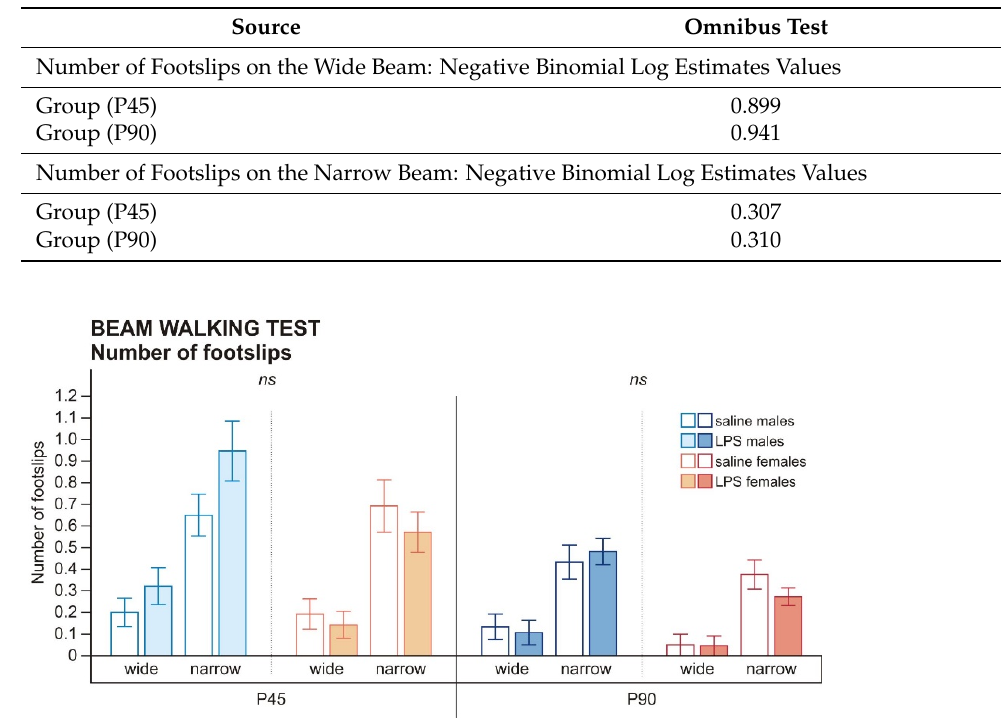
Figure A2. The beam walking test. In general, the number of footslips was very low in all animals, and the difference between LPS-exposed and control rats was revealed neither at P45, nor at P90, by the negative binomial model with log estimates values. In addition, sex differences were not